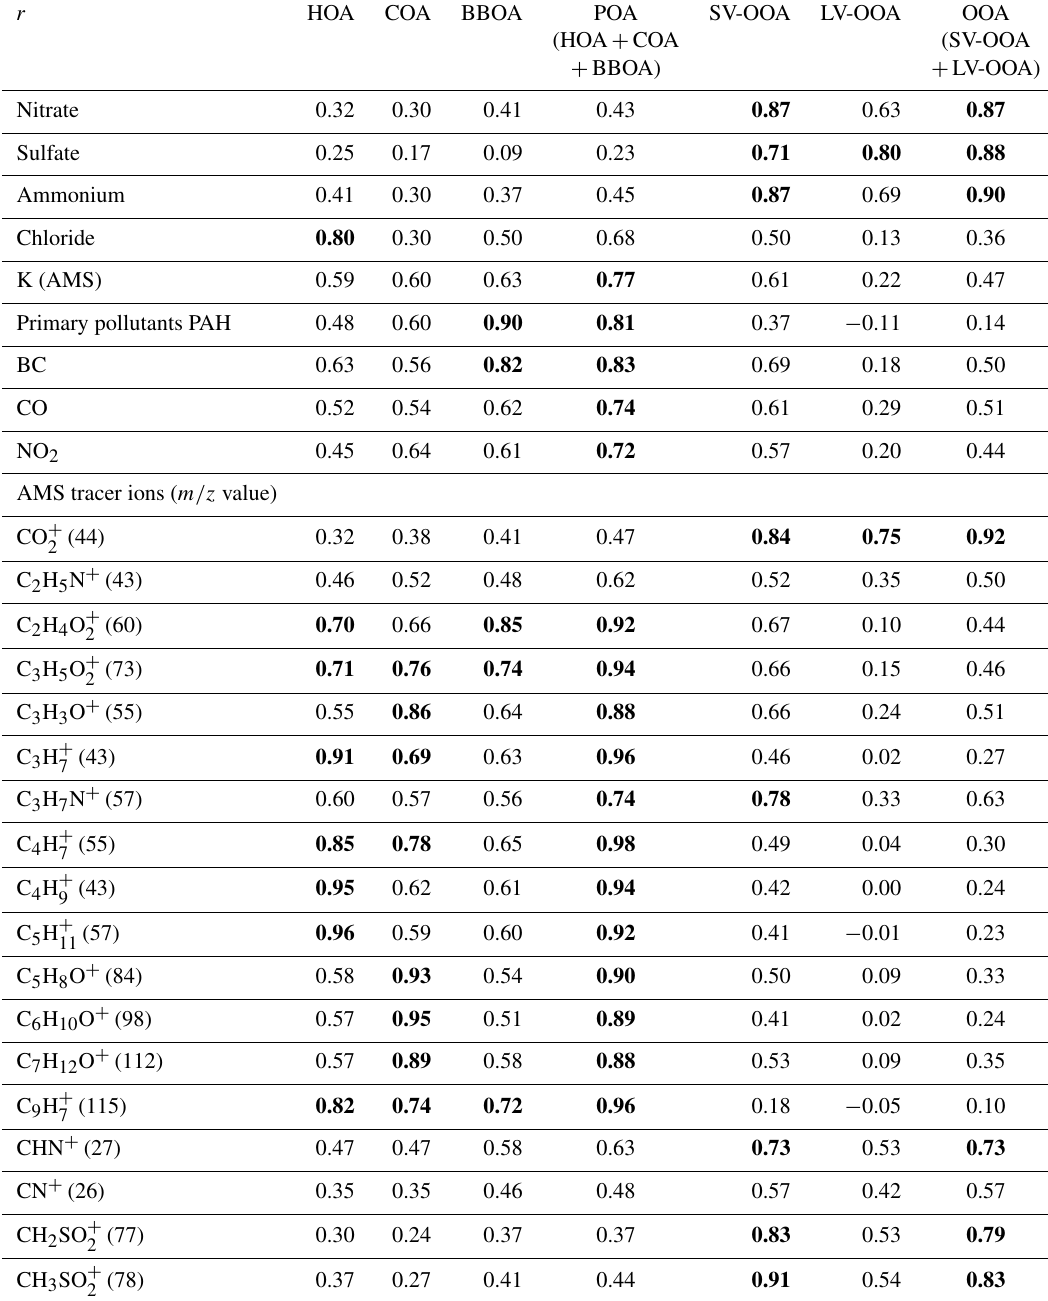
Table 2. Correlation coefficient (Pearson’s r ) for the linear regressions between organic aerosol (OA) factors, including the sum of primary factors (primary OA (POA) = hydrocarbon-like OA (HOA) + cooking OA (COA) + biomass burning OA (BBOA)), as well as the sum of the oxidized factors (oxidized OA (OOA) = semivolatile OOA (SV-OOA) + low-volatile (LV-OOA)), and various particle- and gas-phase species and